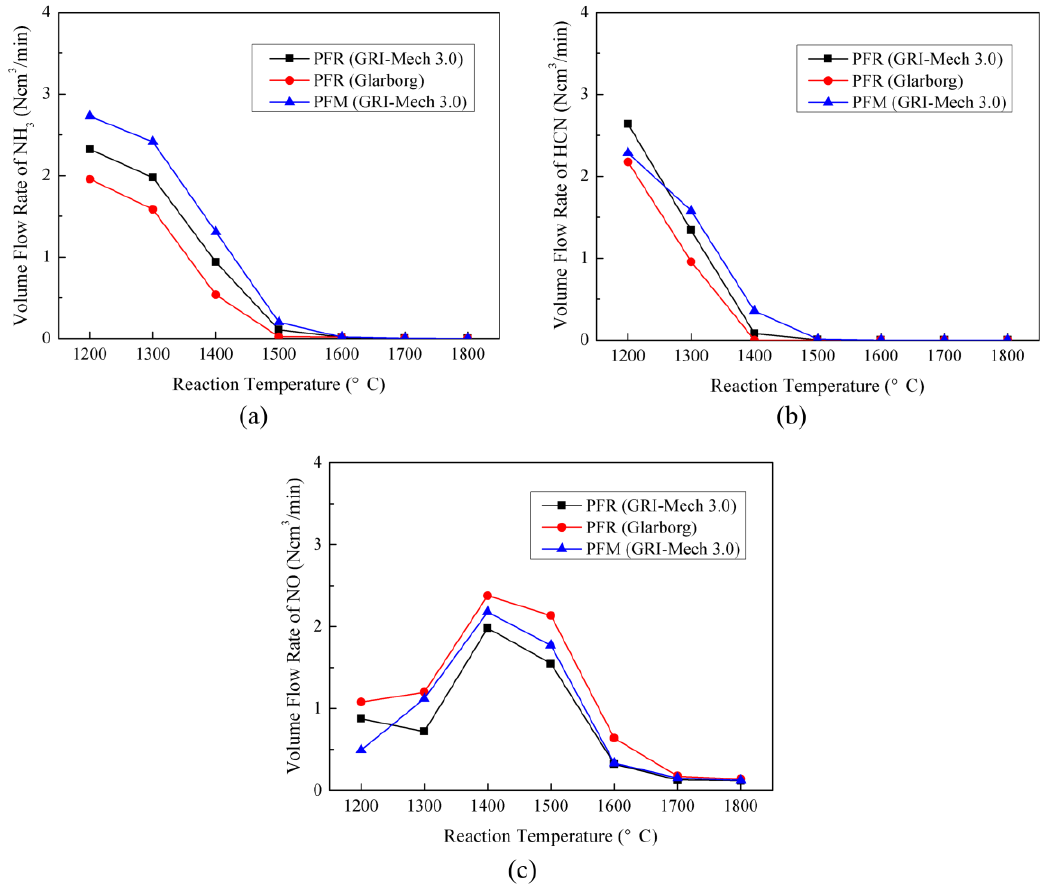
Figure 3. Comparison of different reaction mechanisms and models in staged air combustion: ( a ), ( b ) and ( c ) are the predicted volume flow rates of NH 3 , HCN and NO, respectively, at the main combustion zone exit under the SR of 0.7.